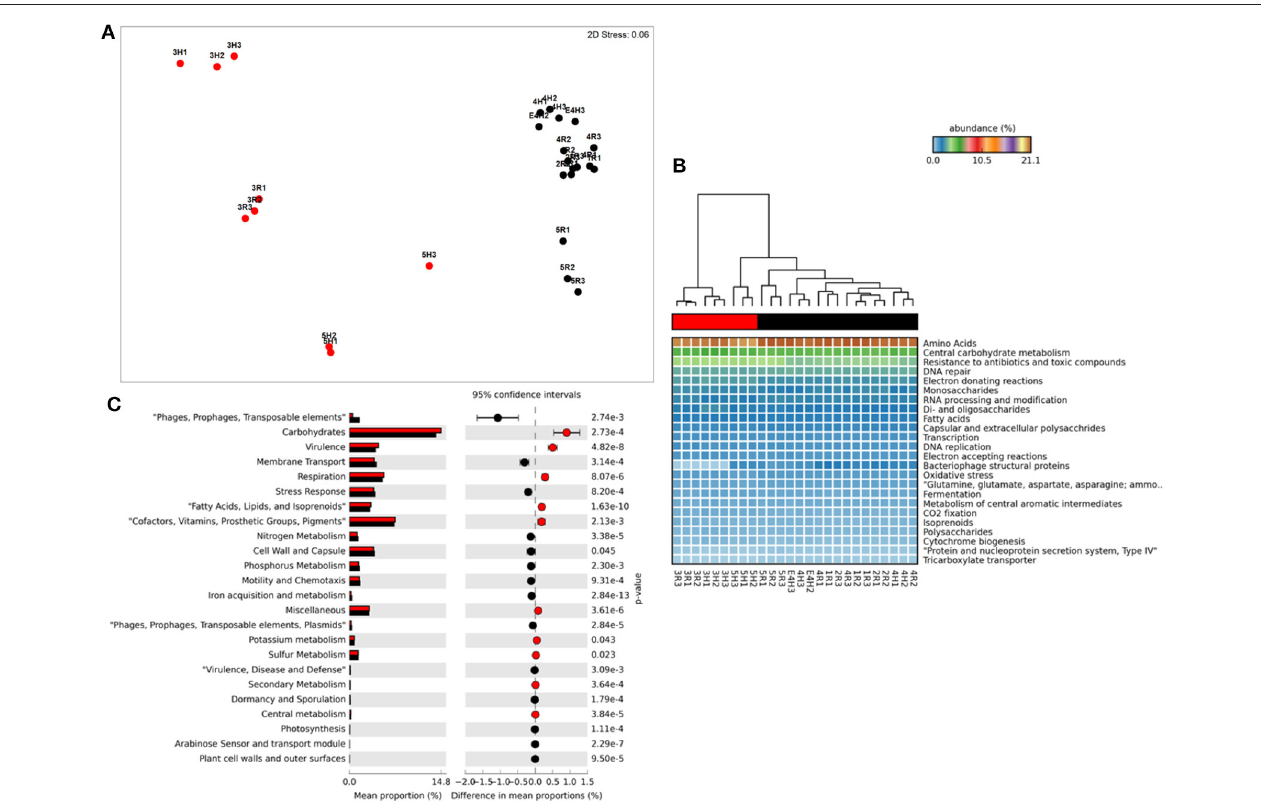
FIGURE 1 | Functional metagenome profiles: (A) non-Metric Multidimensional Scaling (MDS) plot of metagenome functional profile similarity (Bray-Curtis), (B) Heatmap of functional pathway abundance with samples grouped by similarity (UMPGA clustering) and pathways ranked by mean abundance, (C) extended error bar plot of pathways differentially abundant between sample clusters ( > 0.05% difference in abundance, p < 0.05, Welch’s t -test). Color of circles and dendrogram bar denotes sample grouping (Red, slow degrading; Black, rapid